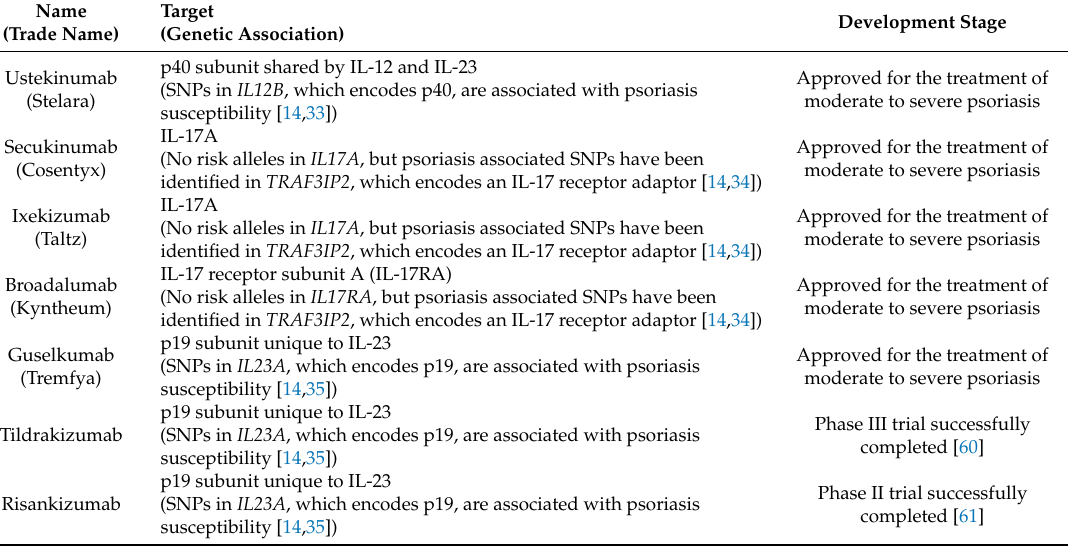
Table 1. Biologics targeting the products of psoriasis susceptibility